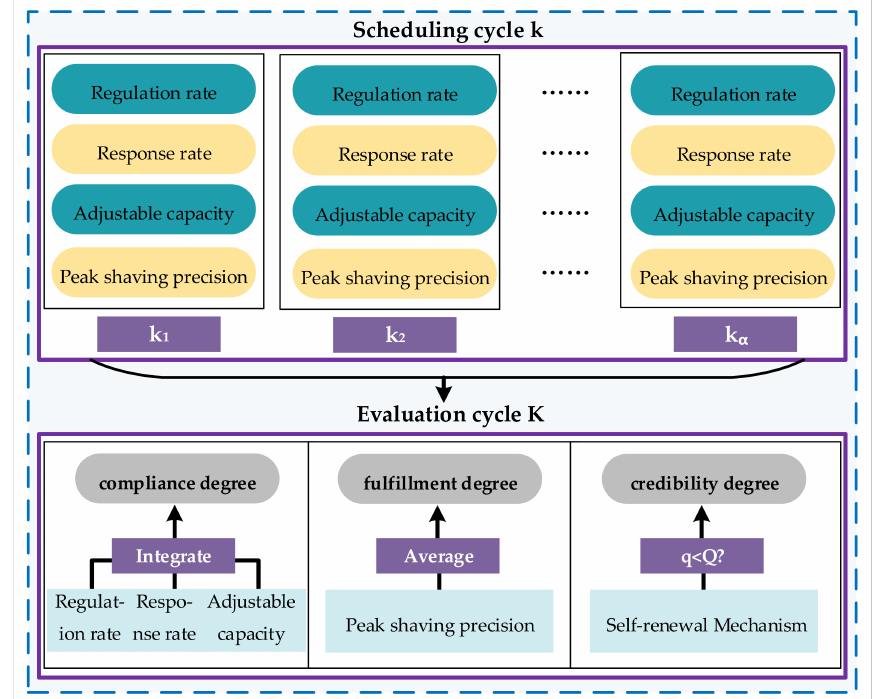
Figure 1. Indexes of DGs for each scheduling and evaluation